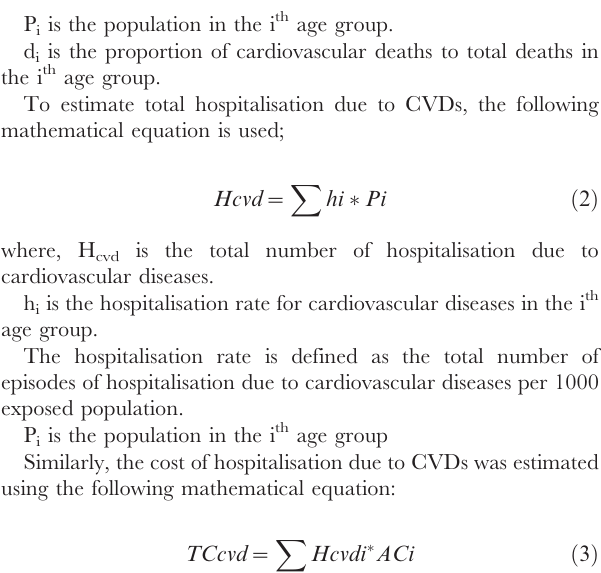
Figure 3. Estimated number of deaths due to CVDs (in 000’s) by age and sex, India, 2010.